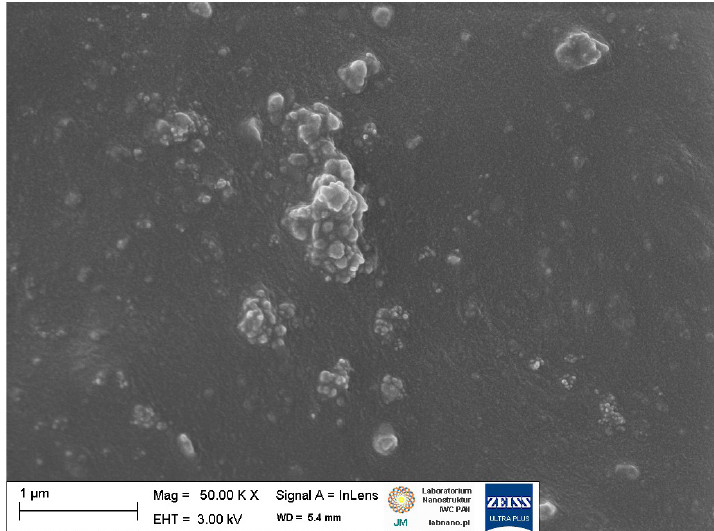
Materials 2023 , 16 , x FOR PEER REVIEW Figure 6. SEM image of the unfilled NR vulcanizate. Figure 6. SEM image of the unfilled NR vulcanizate.